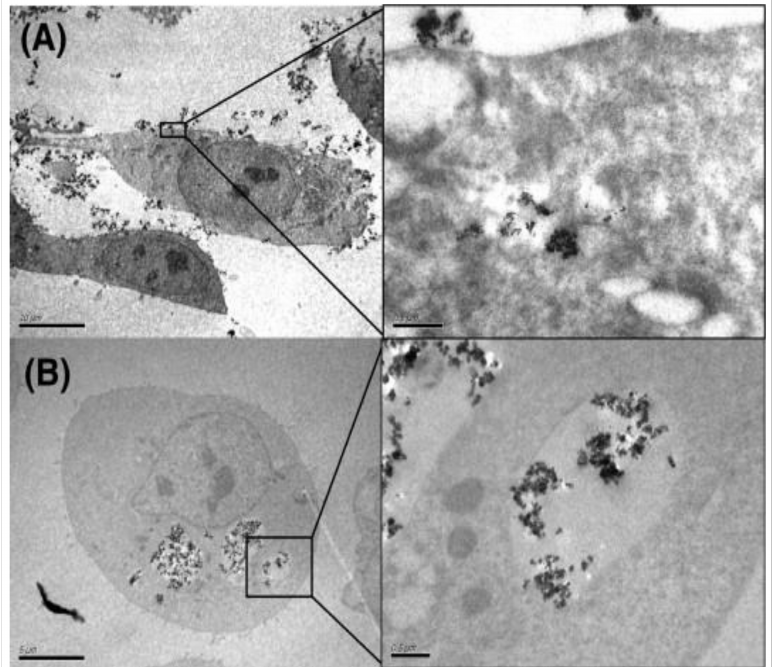
Figure 4. TEM images of 16HBE cells incubated with CB micro- and nanoparticles (MNPs). ( A ) 16HBE cell with CB13 MNPs in a vesicle (scale bars: left (10 µ m); right (0.5 µ m)) ( B ) 16HBE cell containing CB21 MNPs in a vesicle (scale bars: left (5 µ m); right (0.5 µ m)). Reproduced with permission from Ref. [211]. Copyright © 2011